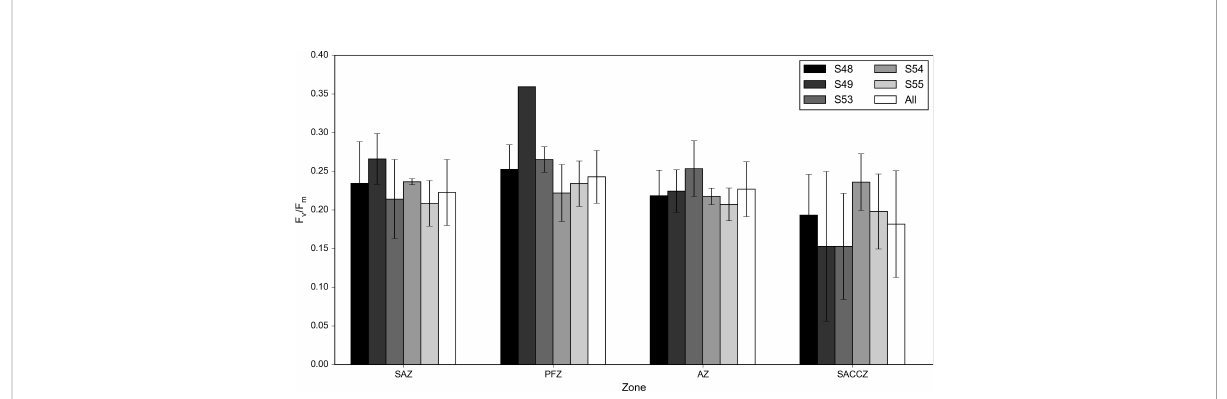
FIGURE 3 Inter-zonal distribution and inter-annual variability of the mean F v /F m . Error bars represent standard deviations. Note that S49 in the PFZ had too few data points to create a standard deviation (n=1).